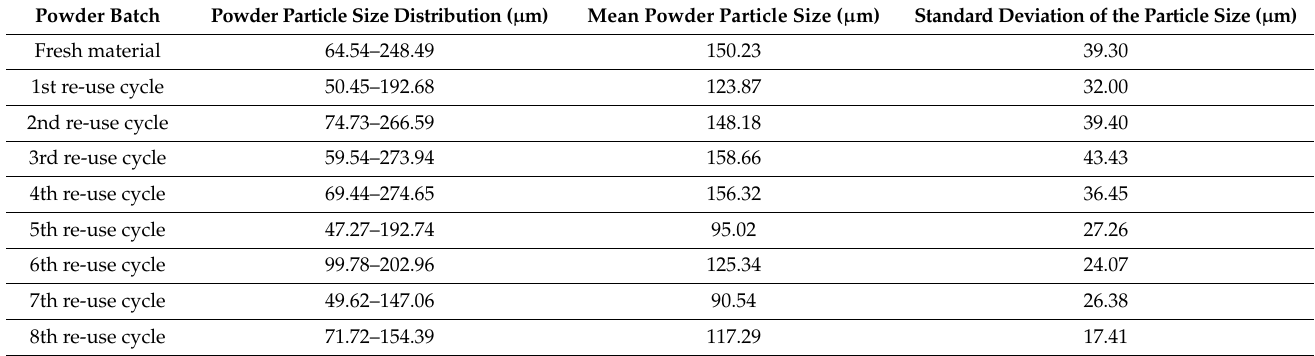
Table 9. Particle size